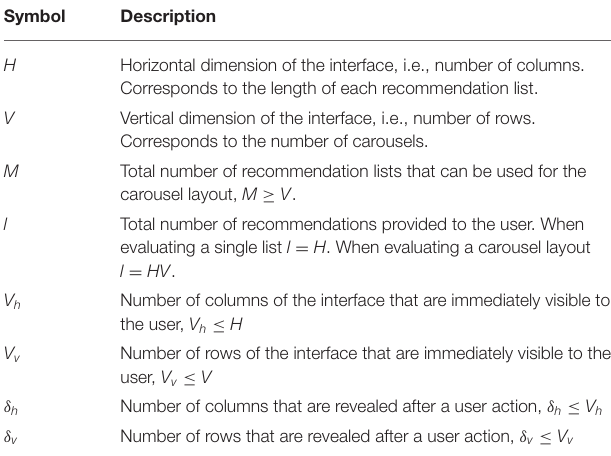
algorithm, an editorially curated one, a genre-specific one, and a further personalized model.